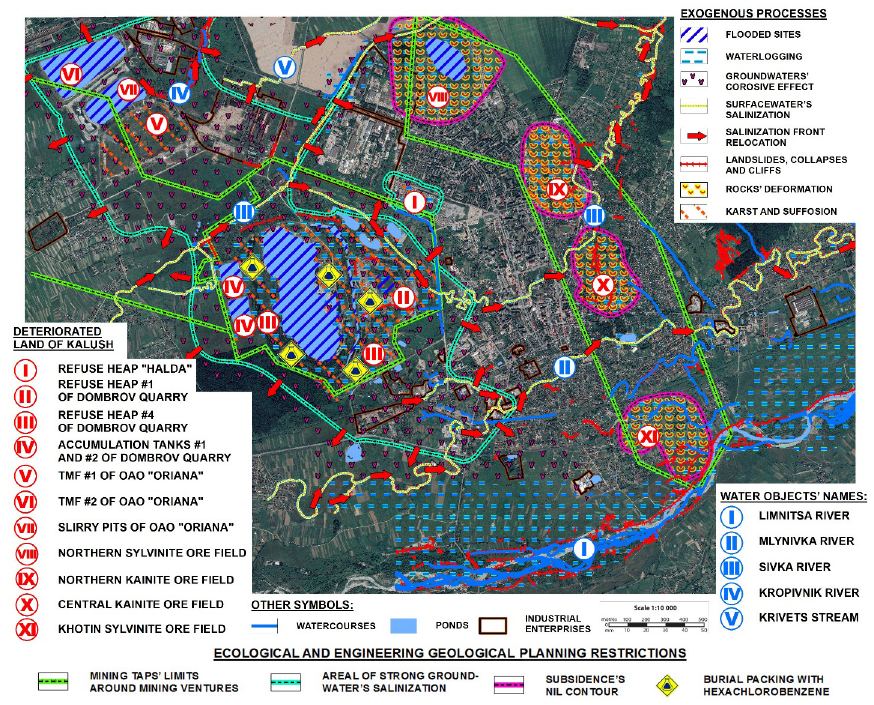
Figure 6. Geoecological situation’s map of Kalush